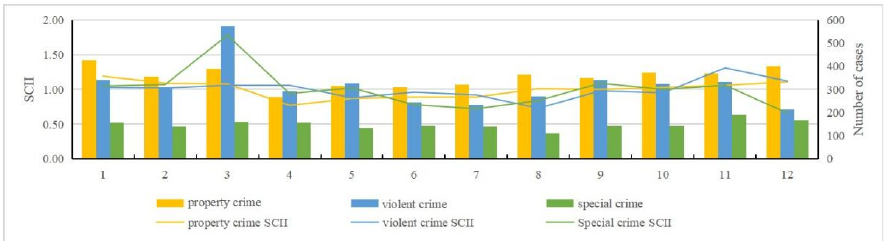
Figure 2. Standardized monthly crime intensity index and number of cases.